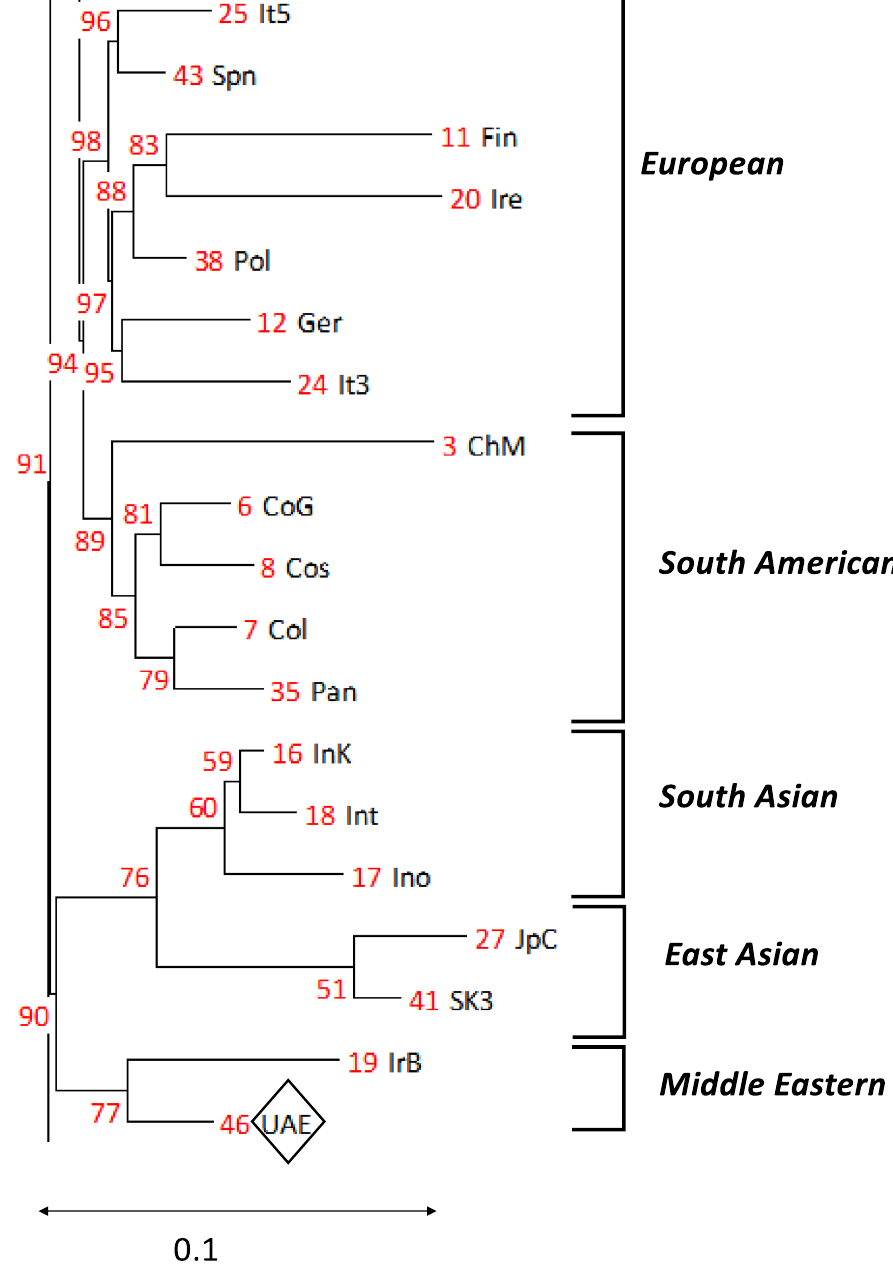
Figure 2. A zoom in view of the neighbor-joining phylogenetic tree showing relatedness between the UAE population and other populations calculated using HLA-A, -B and -DRB1 loci. For the complete phylogenetic tree and description of datasets used and their abbreviations, refer to Table